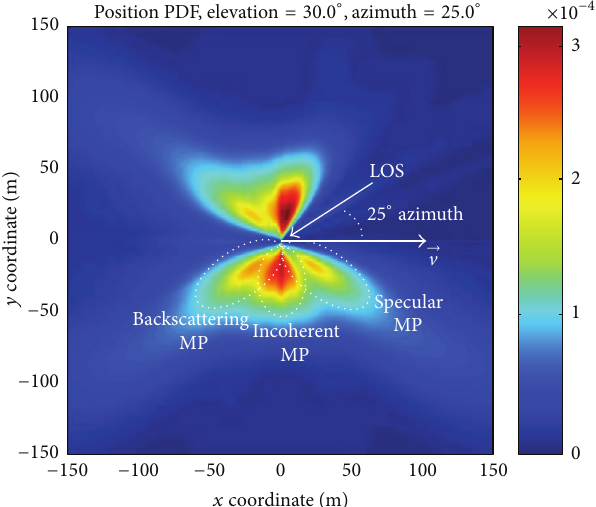
Figure 4: Position probability density function of scatterers extracted from measurements DLR 2002 [14].